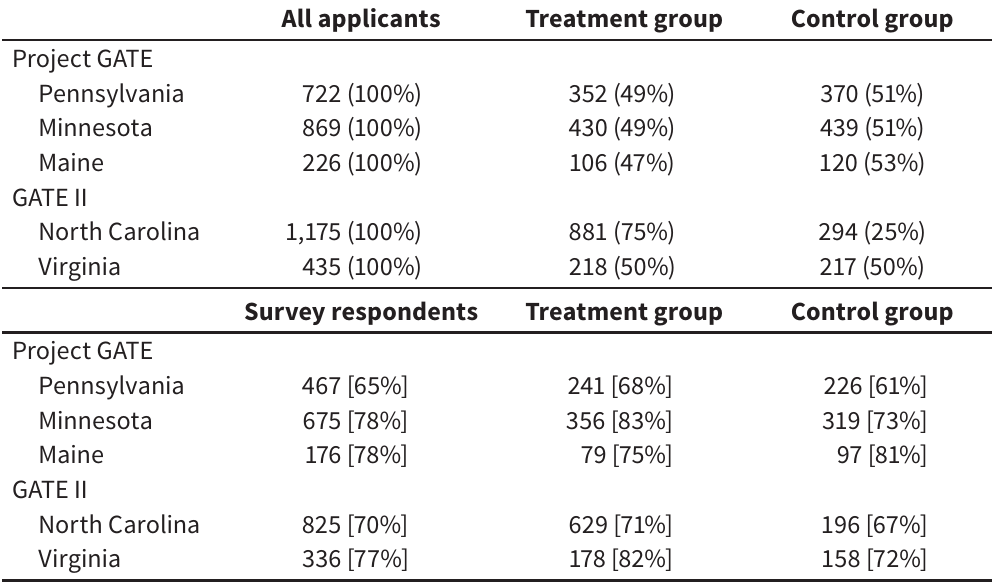
Random assignment of program applicants and survey response